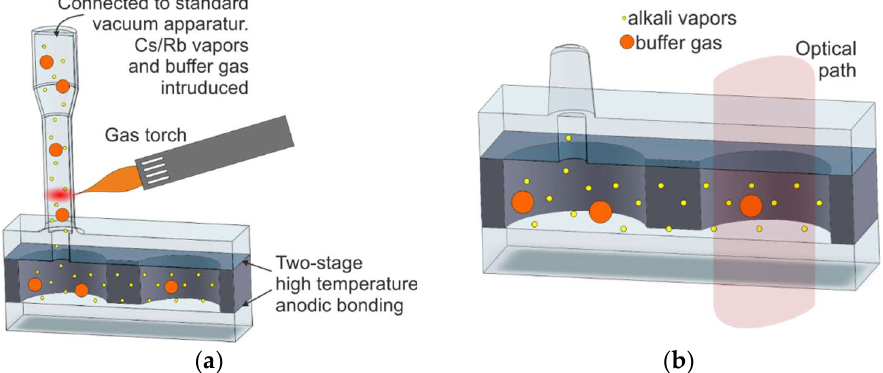
Figure 4. Hybrid process of glassblowing and microfabrication: ( a ) alkali vapor introduction to MEMS structure and cut off with gas torch, ( b ) cross section of the structure.